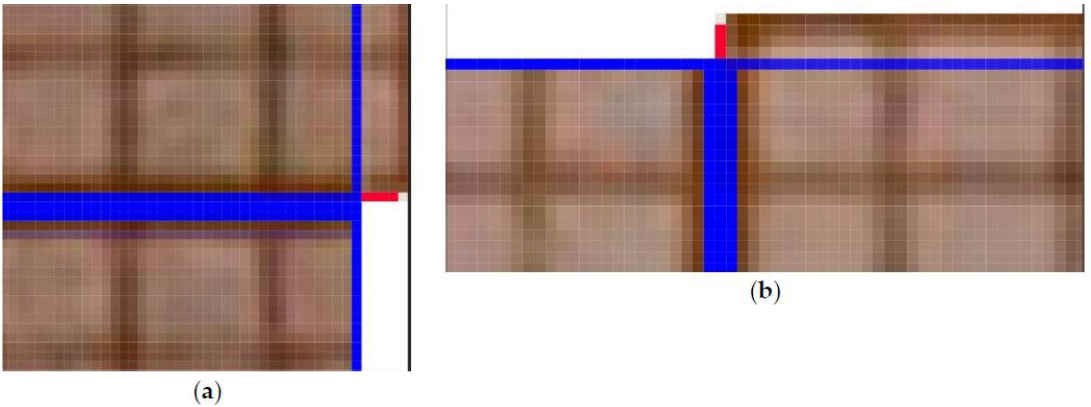
Figure 6. Maximum barrel distortion for: ( a ) the upper, ( b ) right edge of the frame, recorded in the middle of its length.